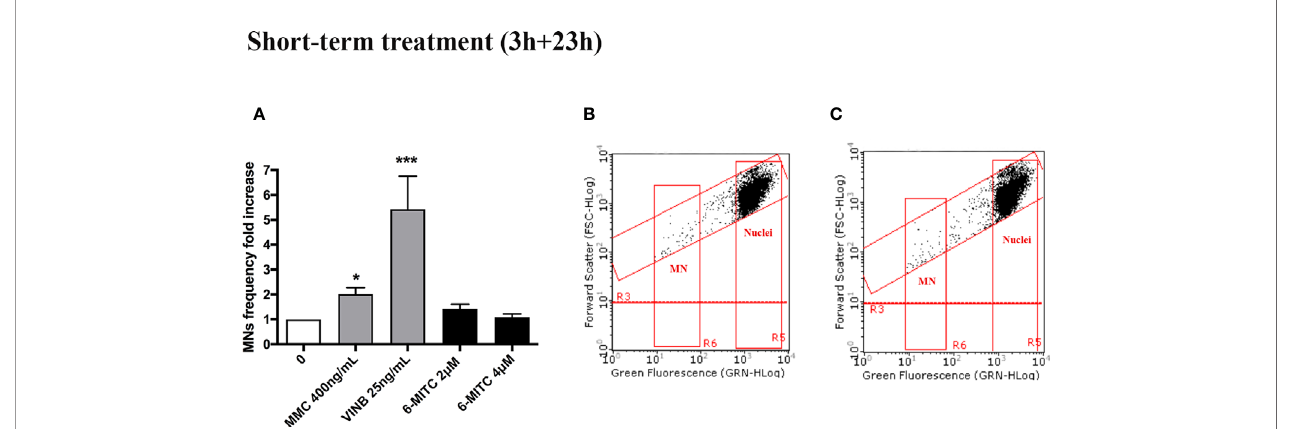
FIGURE 4 | Effect of 6-MITC on mutagenesis after short term treatment. MNs frequency fold increase (A) and dot plot obtained by FCM in the control cultures (B) and 6-MITC 4µM treated cultures (C) on TK6 cells after 3h treatment followed by 23h of recovery in complete medium. Each bar represents the mean ± SEM of fi ve independent experiments. Data were analysed using repeated ANOVA followed by Bonferroni post-test. *p < 0.05 vs 0; ***P < 0.01 vs